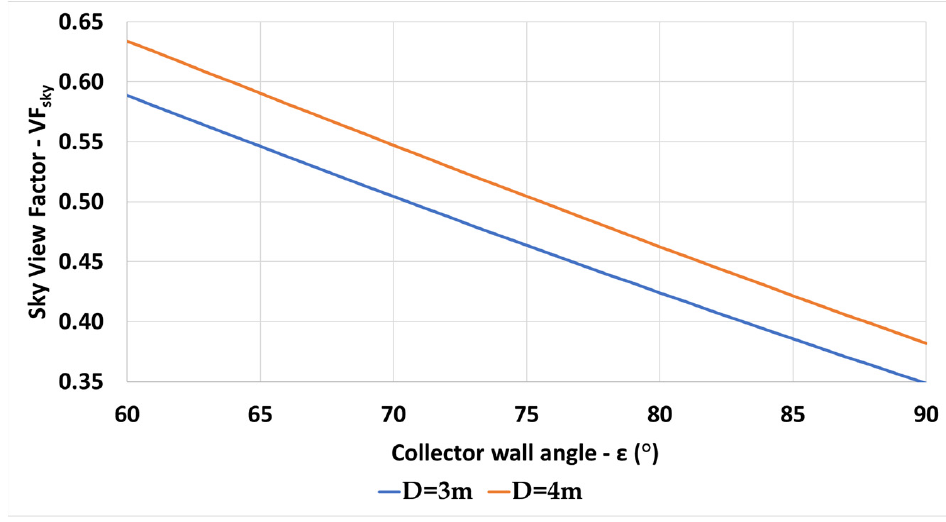
Figure 22. Variation of the sky view factor of collector with wall angle, 𝜀 —bottom collector.